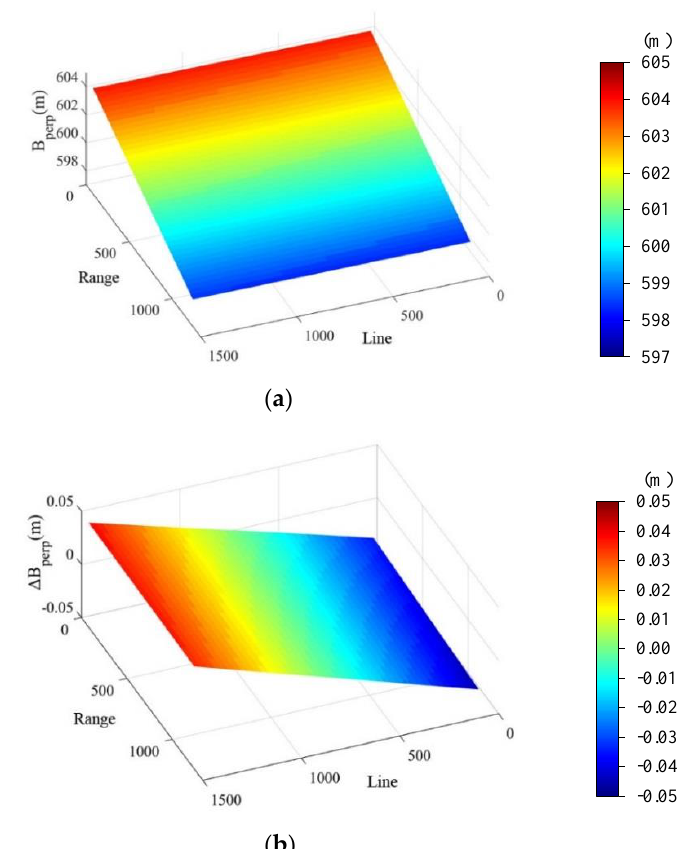
Figure 11. Distribution of vertical baselines (B) obtained by ground control points ( a ) and the difference distribution of vertical baselines ( Δ B) obtained through ground control points, orbits, and least-squares adjustment method ( b ).